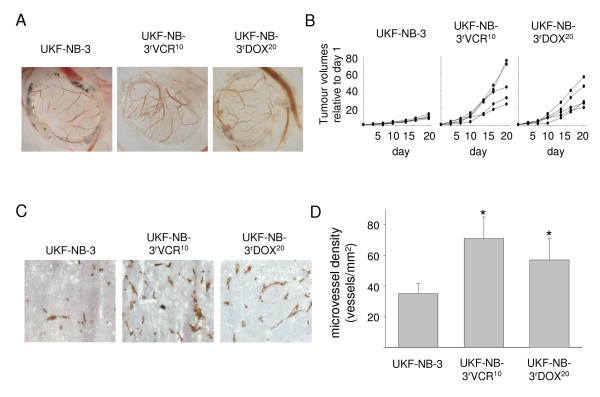
Vessel formation induced by neuroblastoma cells in vivo. A) Representative photographs of vessels induced by neuroblastoma cell lines in the chick chorioallantoic membrane. B) Growth curves of UKF-NB-3, UKF-NB-3rVCR10, or UKF-NB-3rDOX20 tumours in nu/nu mice; UKF-NB-3rVCR10 and UKF-NB-3rDOX20 cells formed statistically significant larger tumours than UKF-NB-3 cells C) Representative photographs of angiogenesis in UKF-NB-3 or UKF-NB-3rVCR10 xenograft tumours in nu/nu mice indicated by red (anti-CD31 antibody-stained) vessels. D) Microvessel density in UKF-NB-3 or UKF-NB-3rVCR10 xenograft tumours in nu/nu mice. * P < 0.05 relative to UKF-NB-3 tumours.